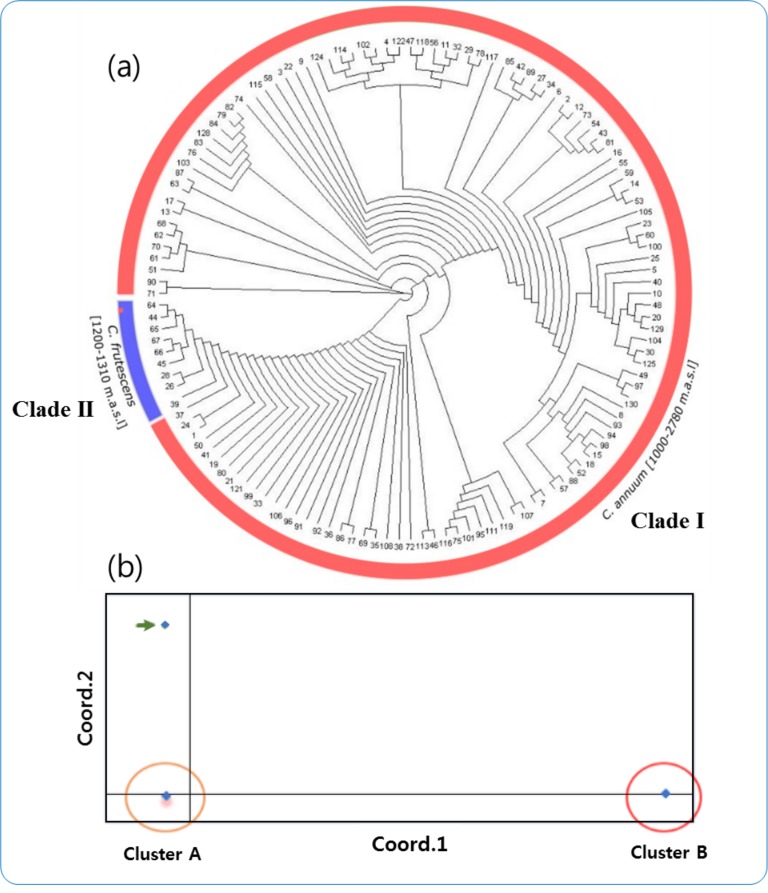
Phylogenic tree and principal-coordinate analysis results confirming the presence of two groups.(a) Unrooted neighbor-joining (NJ) tree of the 142 Capsicum germplasms. (b) Principal-coordinate analysis results showing diversity of Capsicum species clustered in the two subpopulations.